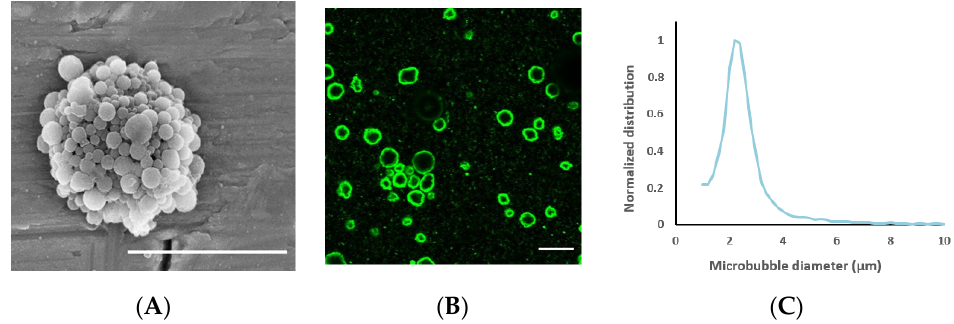
( C ) Figure 2. Example of a binary nanoparticle image ( A ), cell surface image ( B ) and cell image ( C ) as used for image analysis. The scale bars are 20 µm. 3. Results The average nanoparticle diameter was 177 nm (z-average) with a polydispersity in- dex of 0.17 and a zeta potential of − 1.3 mV. The average diameter of the nanoparticle- loaded microbubbles was 2.5 µm (Figure 3) and the concentration 3 × 10 8 microbub- bles/mL. Representative electron microscopy and confocal microscopy images of the mi- crobubbles demonstrate their morphology and nanoparticle loading on the microbubble surface (Figure 3), along with the size distribution of the microbubbles. Cells exposed to nanoparticle-loaded microbubbles and ultrasound showed higher uptake of nanoparticles than cells exposed to ultrasound in the presence of Sonazoid and